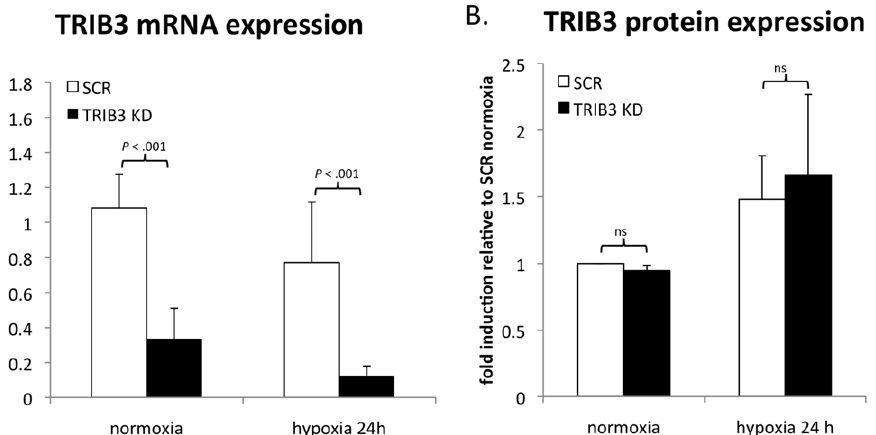
Figure 1. Effect of siRNA mediated knockdown of TRIB3 on mRNA and protein levels. A. Fold induction of TRIB3 mRNA in MDA-MB-231 cells during normoxia and after 24 hours of hypoxia (1% oxygen) treated with negative control siRNA (SCR) or siRNA mediated TRIB3 knockdown (TRIB3-KD) (n=8). B. Fold induction of TRIB3 protein intensity in MDA-MB-231 cells during normoxia or after 24 hours of hypoxia (1% oxygen) treated with negative control siRNA (SCR) or siRNA mediated TRIB3 knockdown (TRIB3-KD) (n=3). Protein intensities were controlled for a -tubulin intensities on same blot. Fold induction are averages ( + SD) relative to levels in cells treated with control siRNA (SCR) during normoxia.